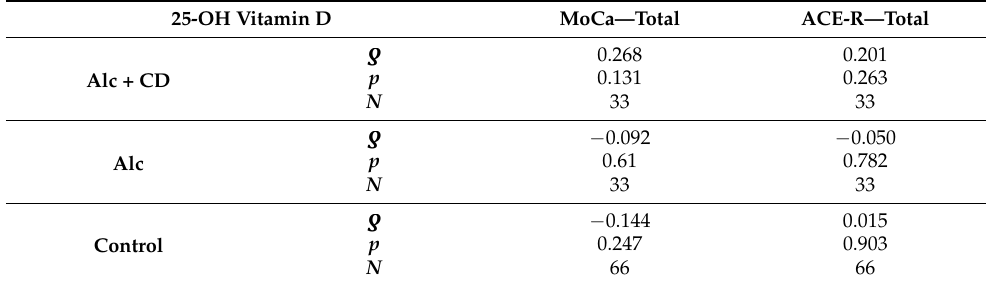
Figure 2. ( a ) Correlation between serum vitamin D levels and cognitive function by groups on the MoCa test. Note: MoCa Total- the Montreal Cognition Assessment total score. ( b ) Correlation be- tween serum vitamin D levels and cognitive function by groups on the ACE-R scale. Note: ACE-R Table 3. Correlations between vitamin D levels and tests by individual groups.